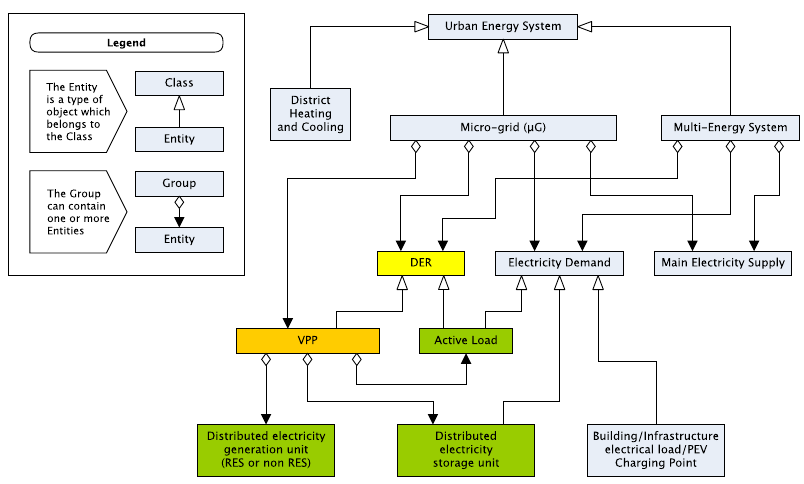
Figure 1. Taxonomy of emerging electrical energy concepts in modern urban energy systems and smart grids. Adopted from [1]. VPP: virtual power plant; DER: distributed energy resource; RES: renewable energy source; PEV: plug-in vehicle.